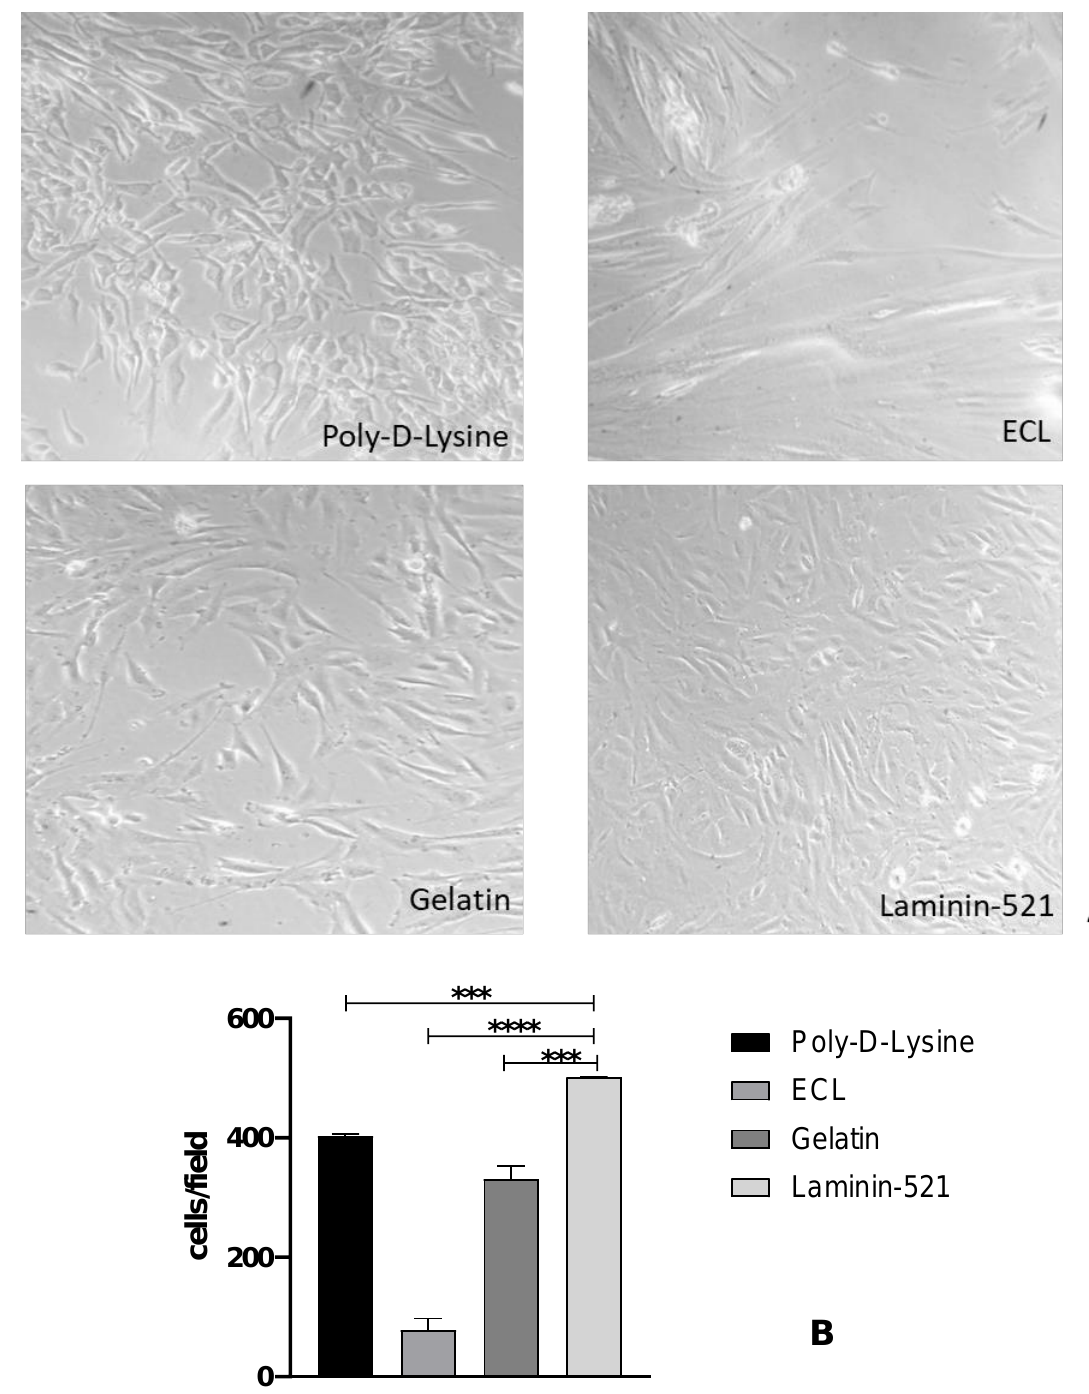
Figure 1. ( A ) Phase contrast representative images of huMPCs seeded in GM (5.0 × 10 5 cells per coverslip) on Thermanox™ coverslips pre-coated with poly-D-lysine hydrobromide, ECL, gelatin or Laminin-521. Cells were cultured for 24 h in standard conditions and viewed by an inverted microscope. Magnification, 20 × . ( B ) Graph with the results of cell counts in the presence of the diverse coating media used. At least 500 cells were counted in 10 different randomly selected fields (*** p < 0.001, **** p < 0.0001).